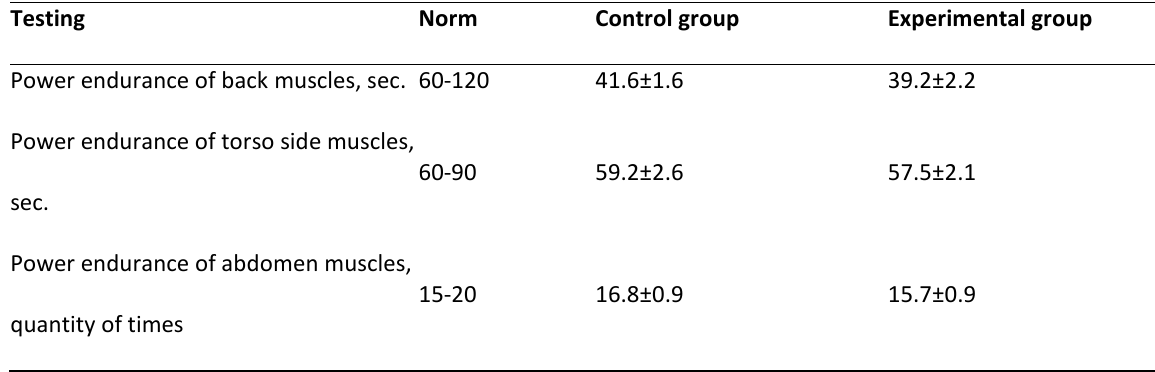
Table1. Comparative analysis of power endurance indicators of control and experimental groups’ children’s torso muscles before pedagogic experiment (by methodic of I.D. Loveyko and M.F.